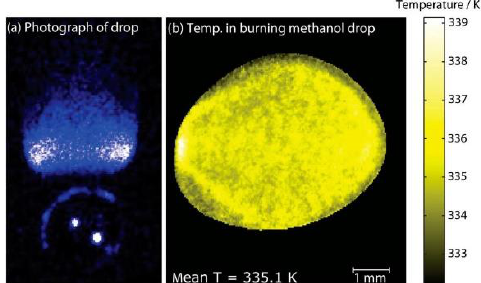
pass filter sets [96]. Reprinted with permission from [96]. Optica Publishing Group, 2008.